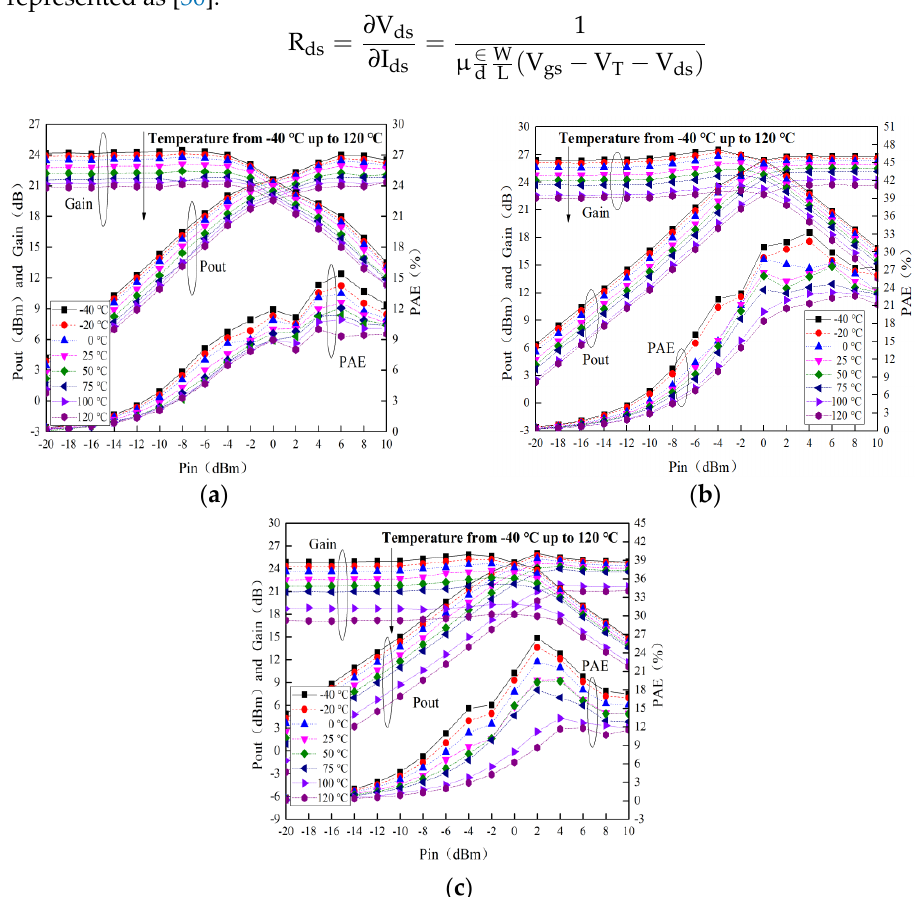
Figure 11. Measured curves of RF output characteristics at different temperatures: ( a ) 2.4 GHz; ( b ) 3.4 GHz; ( c ) 4.4GHz.